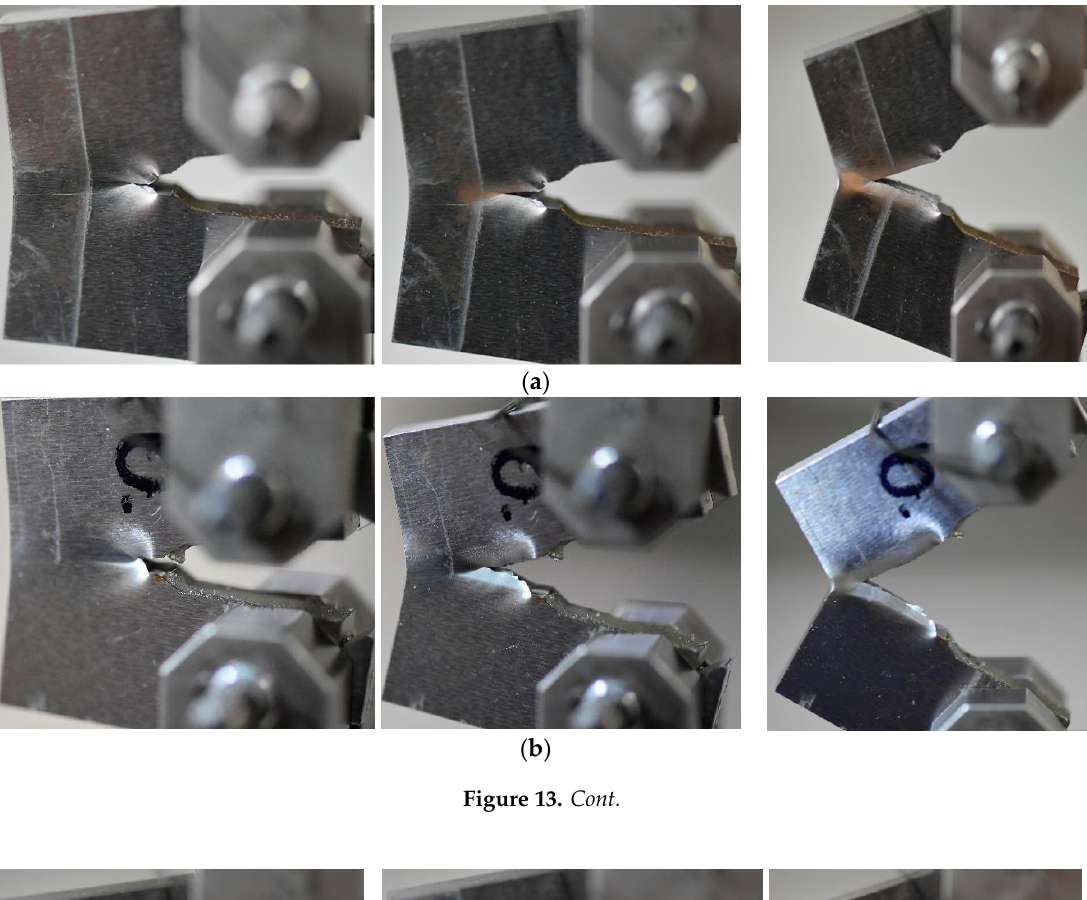
Figure 12. CT mini-specimens before the propagation of the fatigue pre-crack: ( a ) parent material; ( b ) HAZ; ( c ) weld.